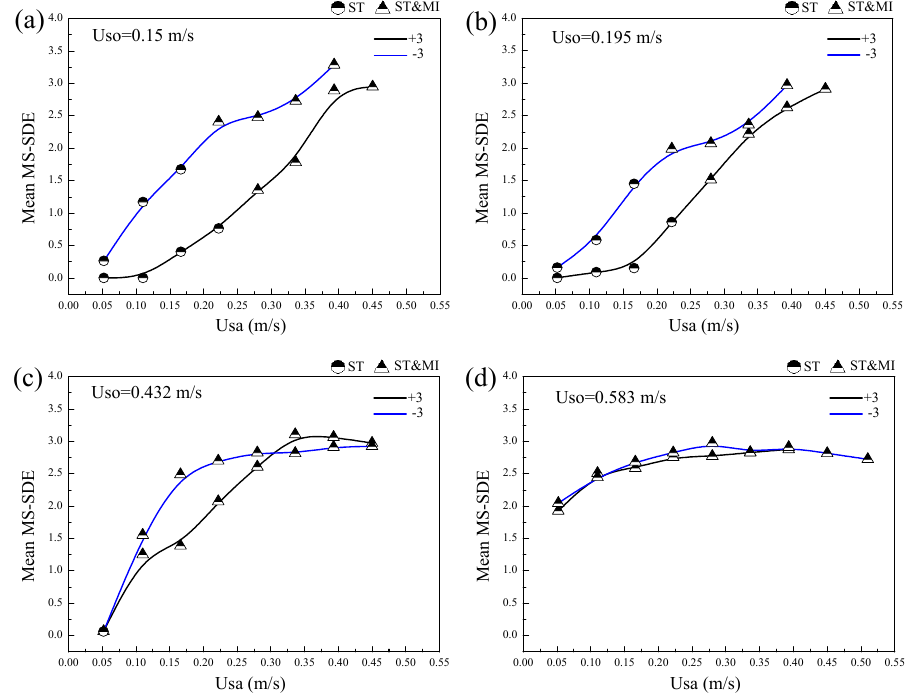
Figure 20. Mean MS-SDE of probe signals for the inclined liquid-liquid flows: ( a ) Uso = 0.15 m/s; ( b ) Uso = 0.195 m/s; ( c ) Uso = 0.432 m/s; ( d ) Uso = 0.583 m/s.